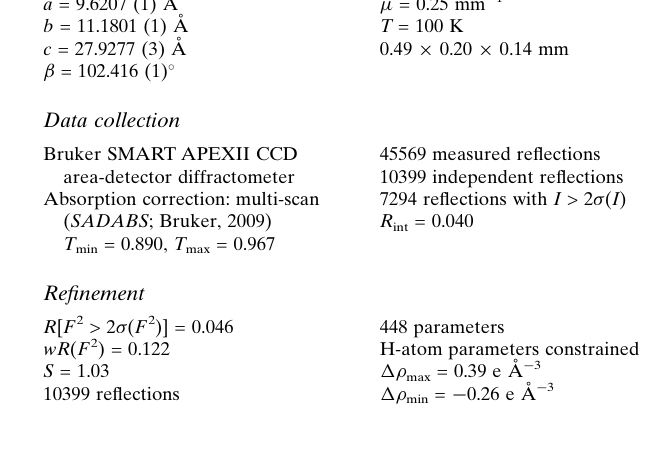
Data collection Bruker SMART APEXII CCD area-detector diffractometer